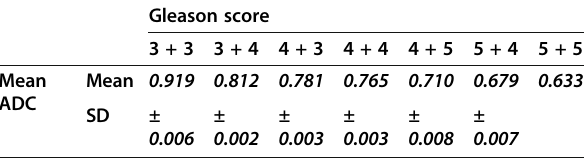
Table 4 Demonstrating the mean ADC value and the standard deviation of each Gleason score in the peripheral zone